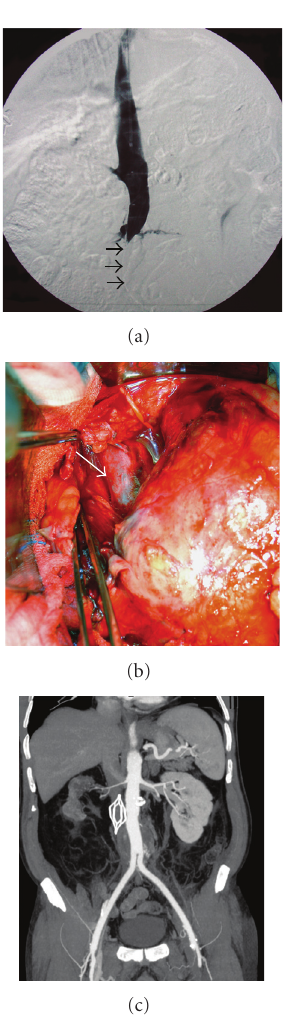
Figure 2: (a) Inferior vena cavagram performed through jugular approach demonstrates collapse of IVC at the AAA level (Black arrows). (b) Operative photograph shows IVC (white arrow) compressed medially and anteriorly by AAA. (c) Eight-month- postoperative coronal CT reconstruction shows patency of the vascular graft and of the IVC at filter level and